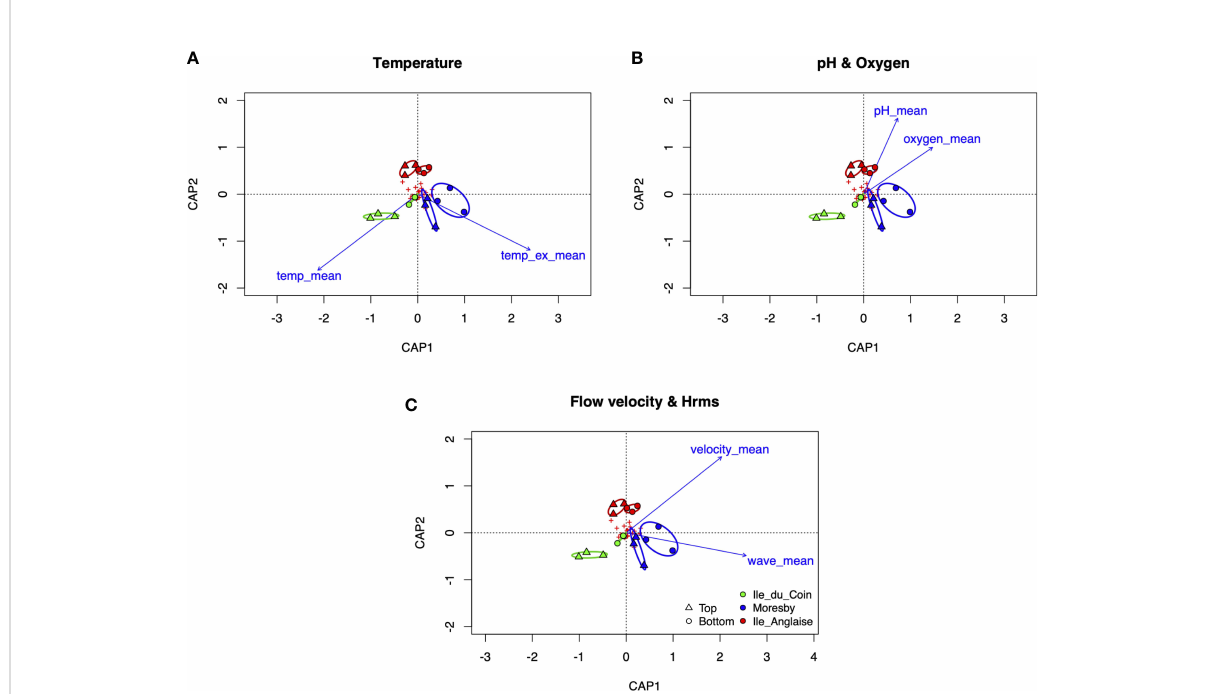
FIGURE 8 Distance-based redundancy analysis (db-RDA) ordinations of top or bottom plate face benthic communities across sites, based on Bray – Curtis distances using fourth-root transformed count data, factored with mean (A) in situ (temp_mean) and ex situ temperatures (temp_ex_mean), (B) pH and oxygen, and (C) fl ow velocity and wave heights. Ellipses represent 95% con fi dence intervals fi tted to the spatial ordination. Red crosses highlight the positioning of benthic groups amongst the